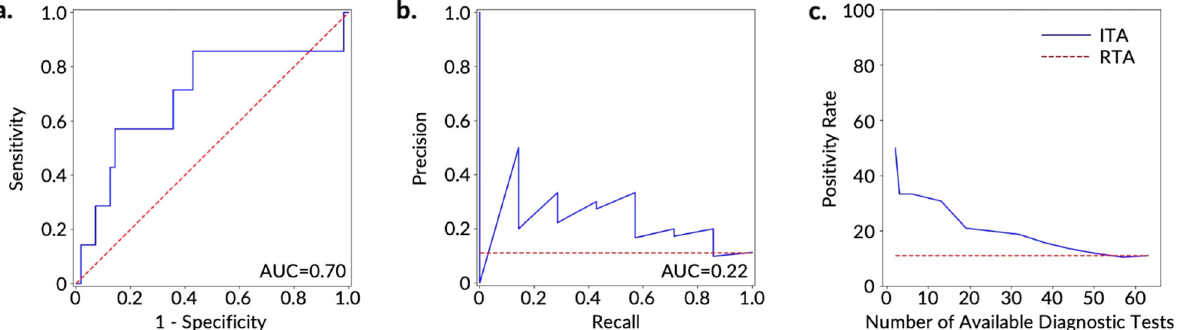
Fig. 4 Prediction and ranking results of the ITA models on the test set of the FHF cohort using RHR digital biomarkers. a ROC and b PRC for the discrimination between COVID-19-positive participants ( n = 7) and -negative participants ( n = 56). The red dashed line shows the results based on an RTA model. c Positivity rate of the diagnostic testing subpopulation as determined by ITA given a speci fi c number of available diagnostic tests. The red dashed line shows the positivity rate of an RTA (null) model.